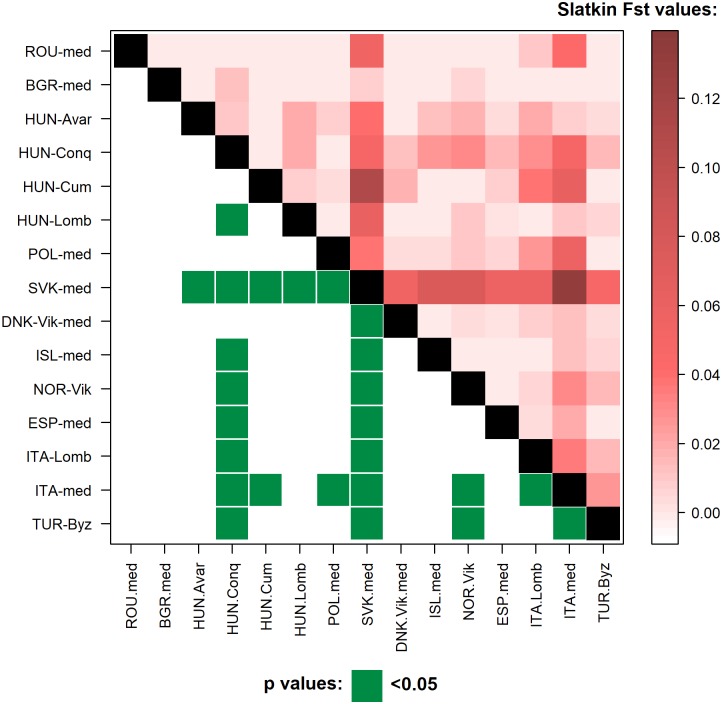
Levelplot of the linearized Slatkin population differentiation (FST) values and significant p values.Lower left corner: significant p values (< 0.05) are indicated in green. Upper right corner: larger Slatkin FST values indicating greater genetic distances are marked by dark red shades. The exact FST and p values and population information are indicated in S6 Table.